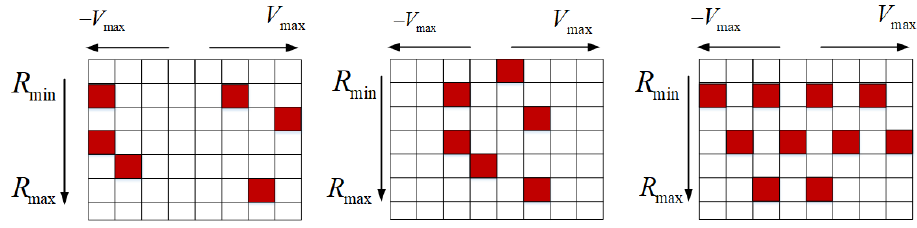
Figure 11. Three simple sampling